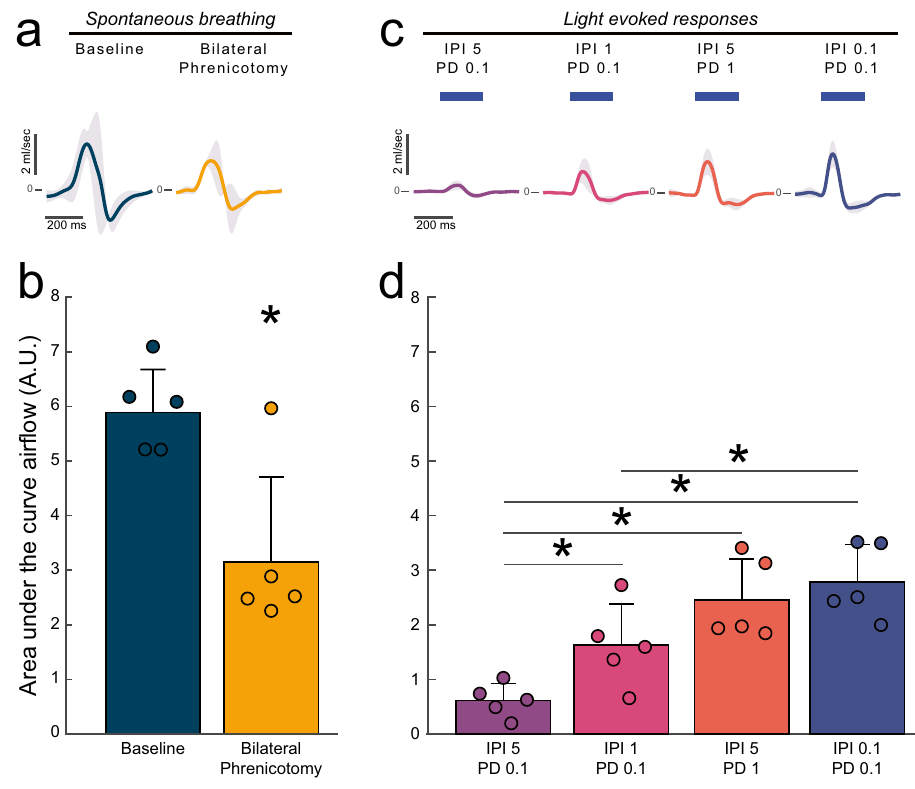
Figure 3. Diaphragm photostimulation can produce respiratory airflow. ( a ) Cycle triggered averages of airflow across the respiratory cycle during spontaneous breathing at baseline and immediately after the bilateral phrenicotomy. The upward deflection represents inspiration. Solid color lines represent mean data, shaded regions represent one standard deviation. The average respiratory airflow under these conditions is shown in panel ( b ). Paired t-tests showed a difference in airflow between baseline and bilateral phrenicotomy ( p = 0.045). ( c ) Stimulus triggered averages of the respiratory flow waveform across all animals (n = 5). Blue bars represent onset and duration of stimulation. Panel ( d ) presents the area under the curve of the evoked airflow traces for the four stimulus conditions tested. Data are presented as mean + 1 stdev with scatter showing data for individual animals. One way repeated measures ANOVA showed an effect of stimulation on airflow ( p < 0.001), black lines indicated significant differences between groups ( p <